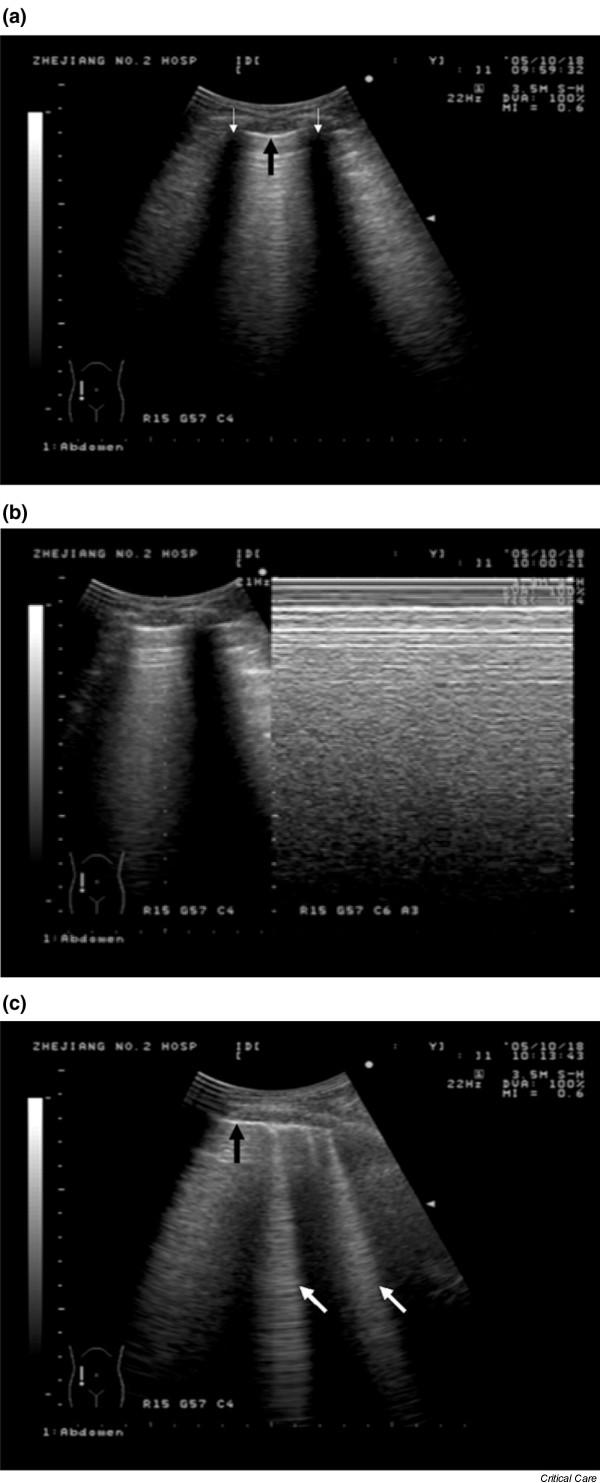
Conventional ultrasonic signs in the lung. (a) The pleural line (black bold arrow) is a roughly horizontal hyper-echoic line between upper and lower ribs, identified by acoustic shadows (white arrow). (b) Lung-sliding is a forward-and-back movement of visceral pleura against parietal pleura in real-time motion. In time-motion mode, it includes motionless parietal tissues over the pleural line and a homogenous granular pattern below it (right image). (c) Comet-tail artifacts (white bold arrows) are hyper-echoic reverberation artifacts arising from the pleural line, laser-beam-like and spreading up to the edge of the screen.